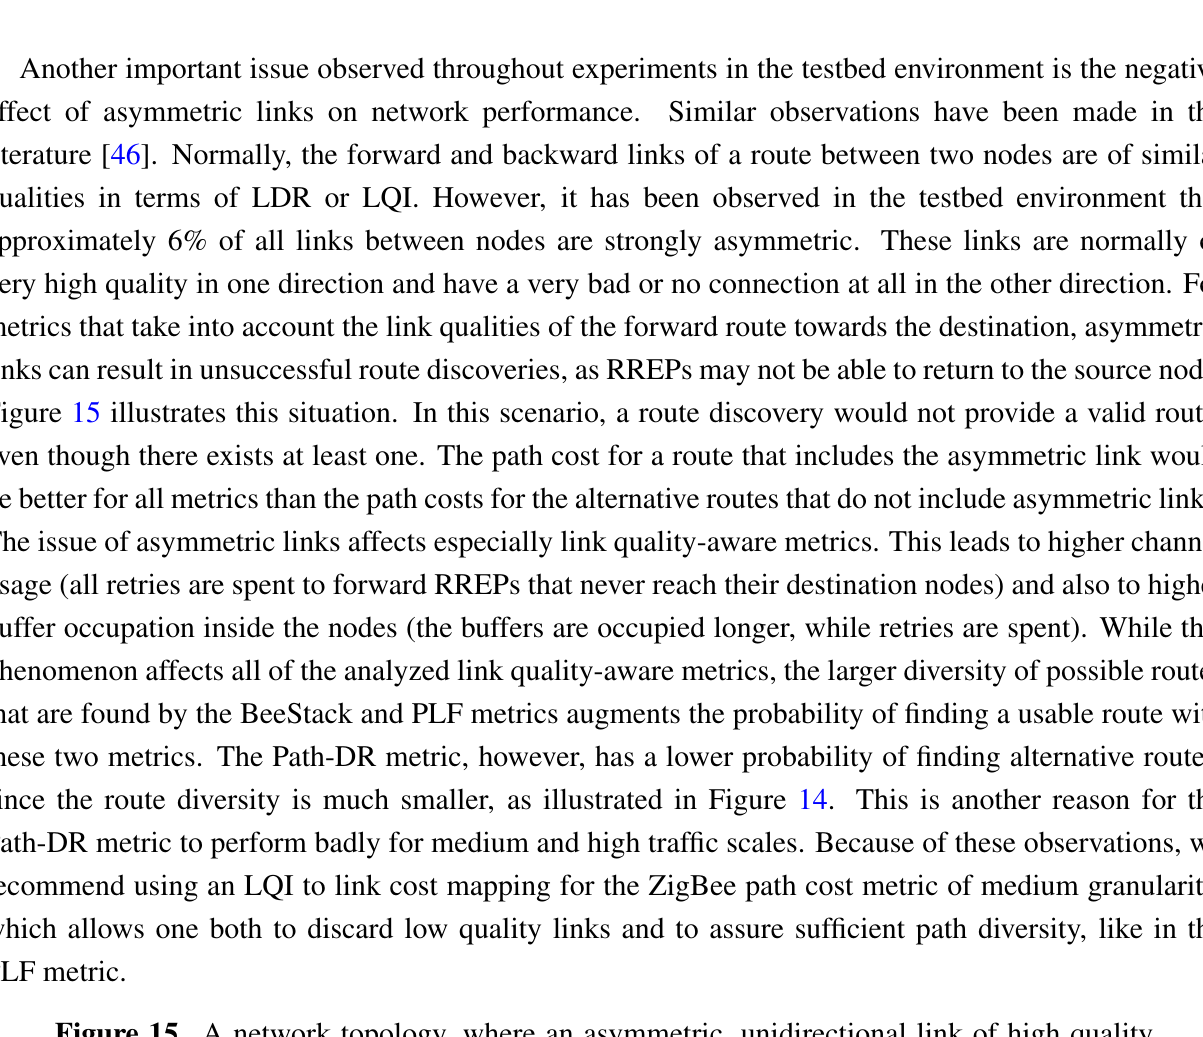
Figure 15. A network topology, where an asymmetric, unidirectional link of high quality (dashed line) is likely to be chosen by the routing metrics, even though its asymmetry impedes RREPs sent by the destination (D) from being returned to the source node (S). The numbers represent the LDRs of the